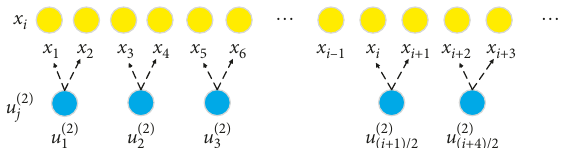
Figure 1: Multiscale coarse granulation of the time series with scale 2.